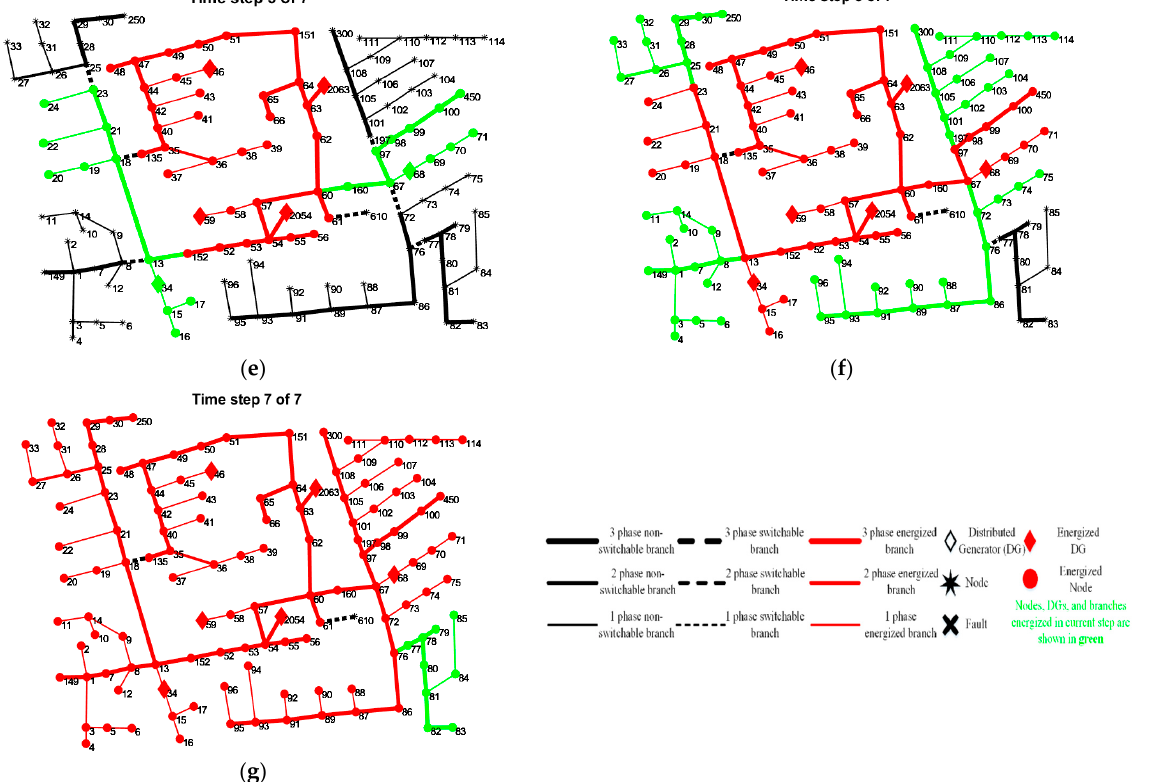
Figure 5. The restoration sequence of the restored microgrid with ( a – g ) representing restoration steps 1, 2, 3, to 7, respectively.